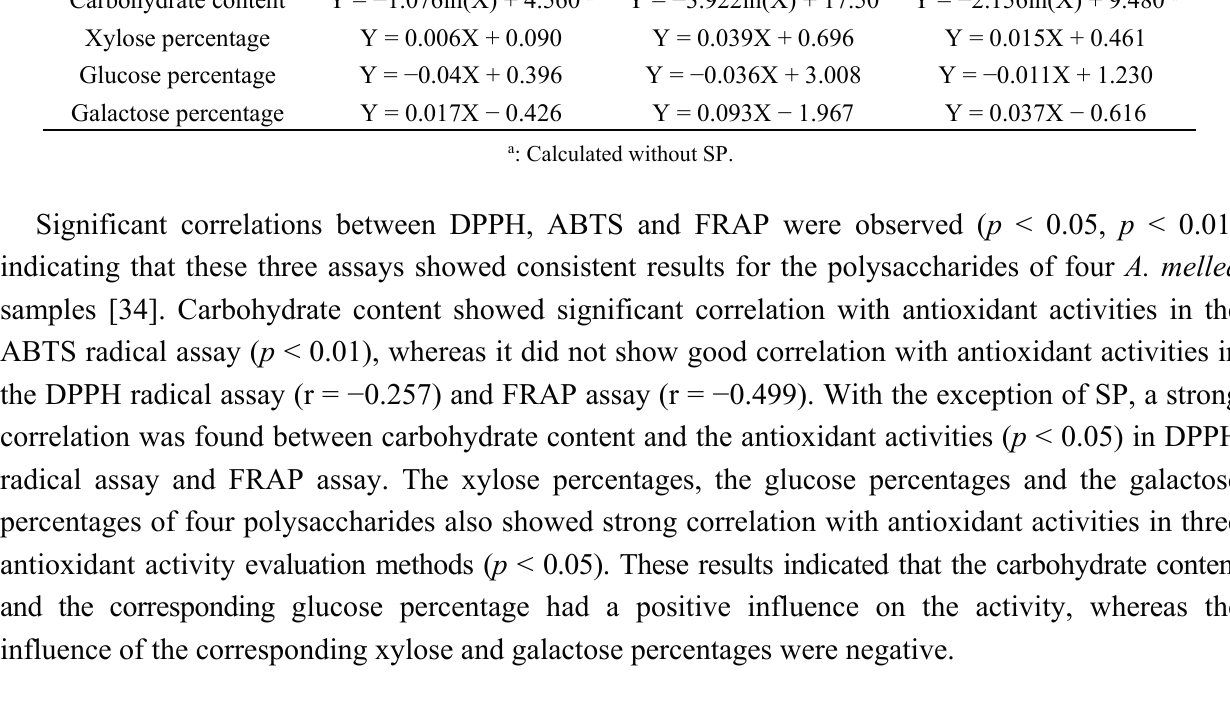
Table 6. The linear regression equations of the relation between carbohydrate content/monosaccharide percentage (X) and antioxidant activities (Y). DPPH ABTS FRAP Carbohydrate